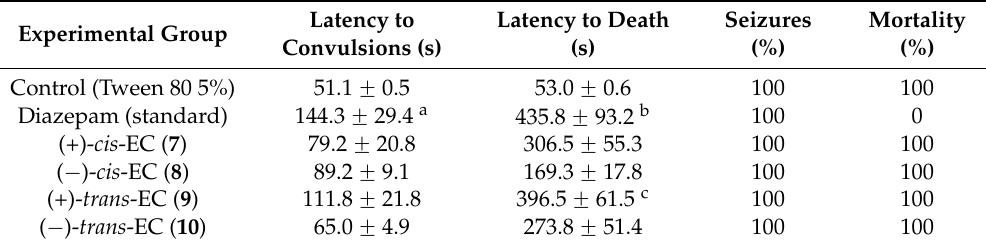
Table 4. EC isomers effect on strychnine-induced seizures